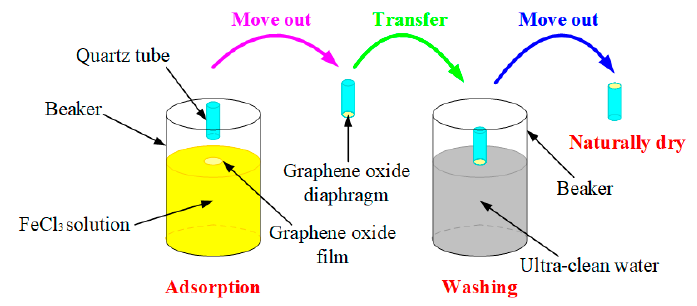
Figure 7. Operation of GO sensing diaphragm on a quartz tube.